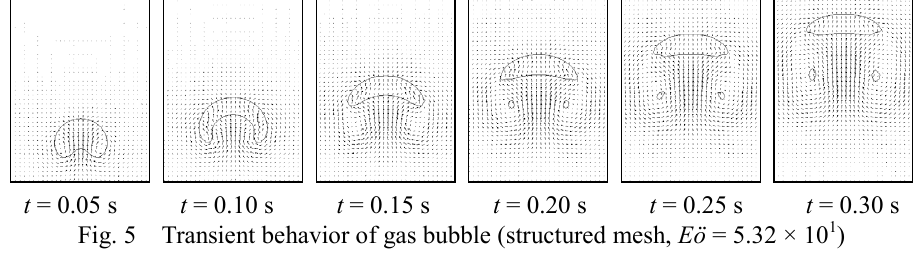
Transient behavior of gas bubble (structured mesh, Eö = 5.32 × 10 1 )